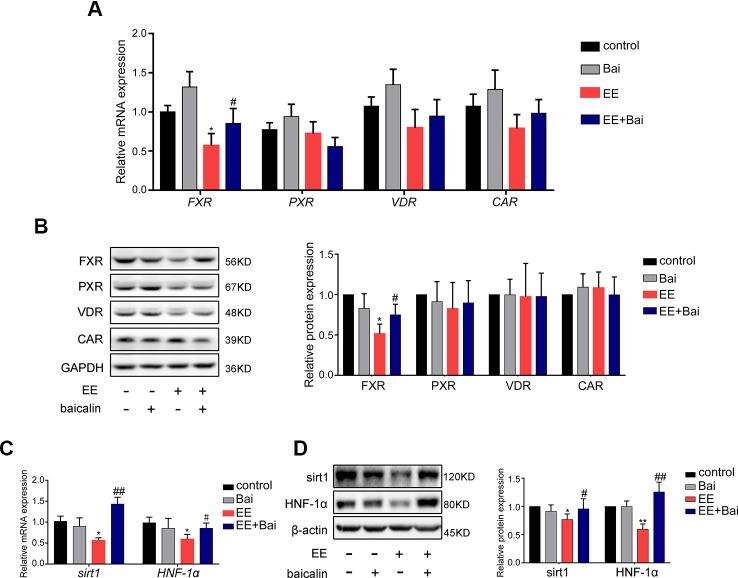
Baicalin restored the mRNA and protein level of FXR, Sirt1, HNF-1α in vivo. (A) The mRNA expression of nuclear receptors of FXR, PXR, VDR, and CAR. (B) The protein level of FXR, PXR, VDR, and CAR. (C) The mRNA expression of Sirt1 and HNF-1α. (D) The protein level of Sirt1 and HNF-1α. Data are presented as the mean ± SD (n = 6). *p < 0.05 and **p < 0.01 versus the control group, #p < 0.05 and ##p < 0.01 versus the EE group.